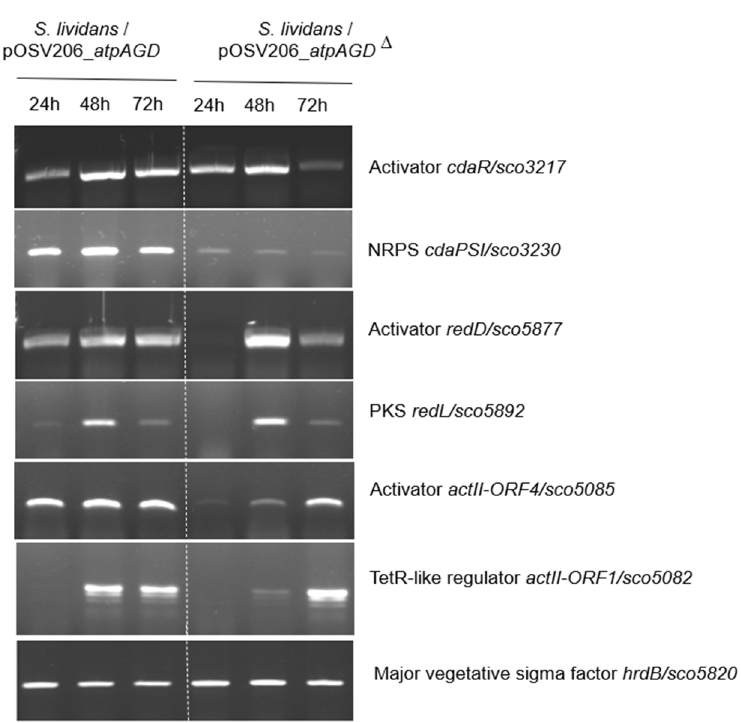
Figure 3. Determination by RT-PCR of the level of expression of the genes encoding the activator CdaR/SCO3217 and the type I peptide synthase SCO3230 of the CDA cluster; the activator RedD/SCO5877 and the polyketide synthase RedL/SCO5892 of the RED cluster, and of the activator ActII-ORF4/SCO5085 and the regulator ActII-ORF1/SCO5082 of the ACT cluster as well as HrdB/SCO5820, as internal control, using the primers specific of each gene listed in Table S1. RNA was extracted from in S. lividans /pOSV206_ atpAGD and S. lividans /pOSV206_ atpAGD ∆ grown on solid HT medium for 48 h.